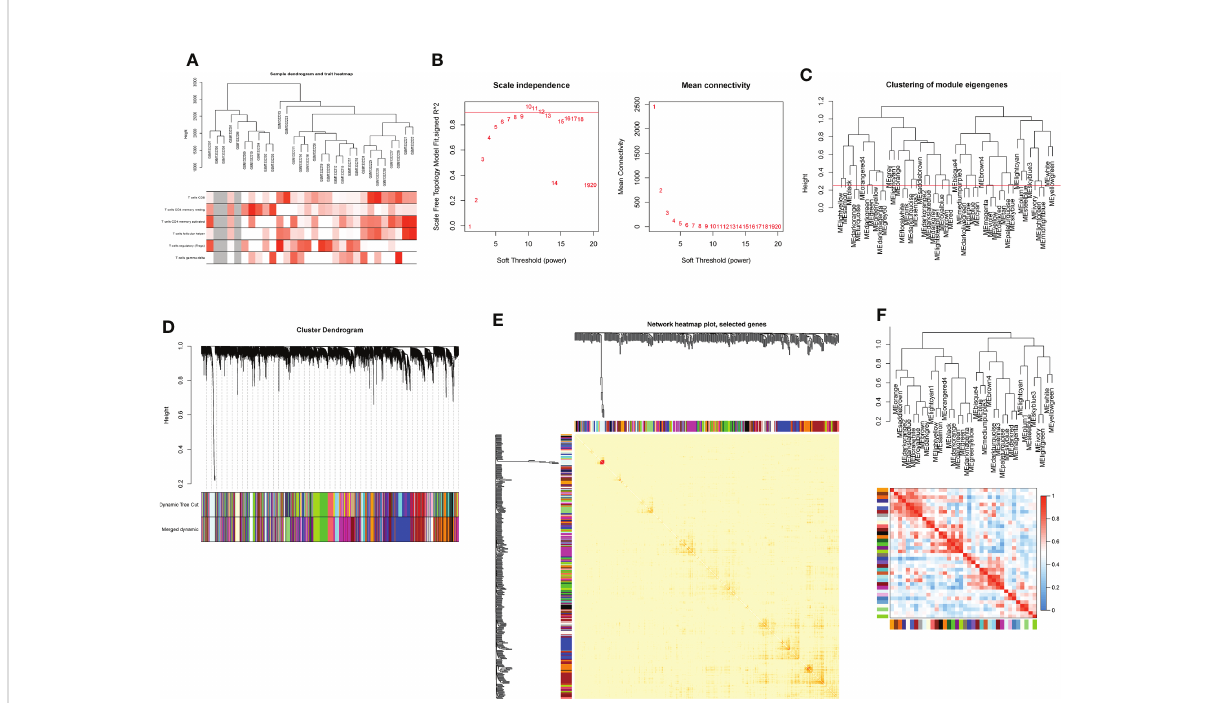
FIGURE 1 Construction of WGCNA co-expression network. (A) Sample clustering dendrogram with tree leaves corresponding to individual samples. (B) Soft threshold b = 7 and scale-free topological fi t index (R2). (C) Clustered dendrograms were cut at a height of 0.25 to detect and combine similar modules. (D) Shows the original and combined modules under the clustering tree. (E) Collinear heat map of module feature genes. Red color indicates a high correlation, blue color indicates the opposite results. (F) Clustering dendrogram of module feature